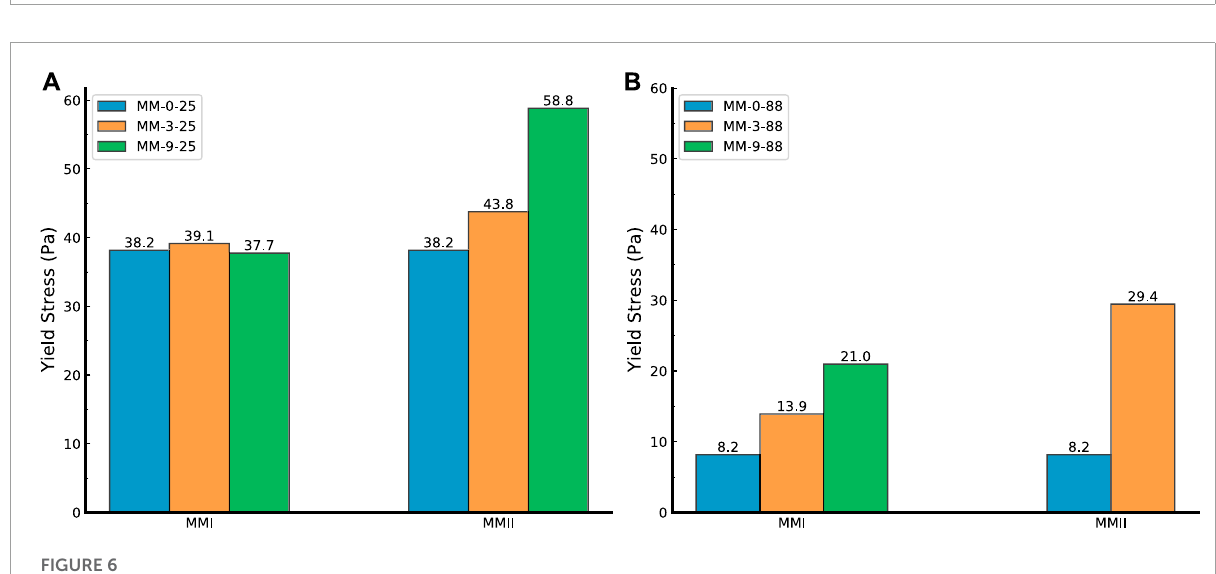
FIGURE 6 Yield point (yield stress) of slurry samples. (A) Slurry samples (mixed with MMII and MMI, respectively) tested under 25 ° C; (B) slurry samples (mixed with MMII and MMI, respectively) tested under 88 ° C; MMI refers to type I micro-sized magnesium oxide; MMII refers to type II micro-sized magnesium oxide; MM refers to micro-sized magnesium